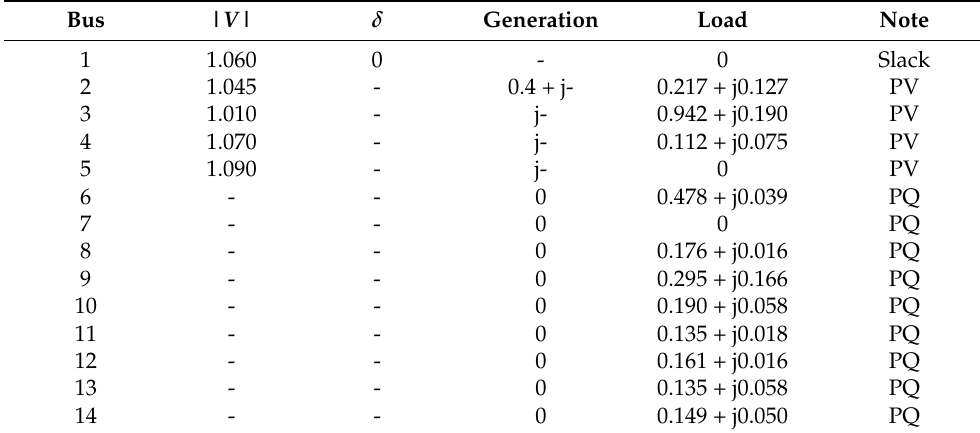
Table 3. Test system bus data (in pu).